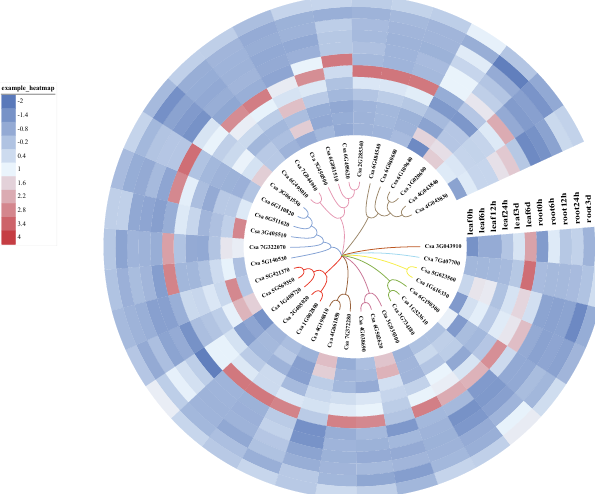
Figure 7. Expression profile of CsaGRAS genes in di ff erent tissues under cold treatment duration. The data are clustered according to phylogenetic